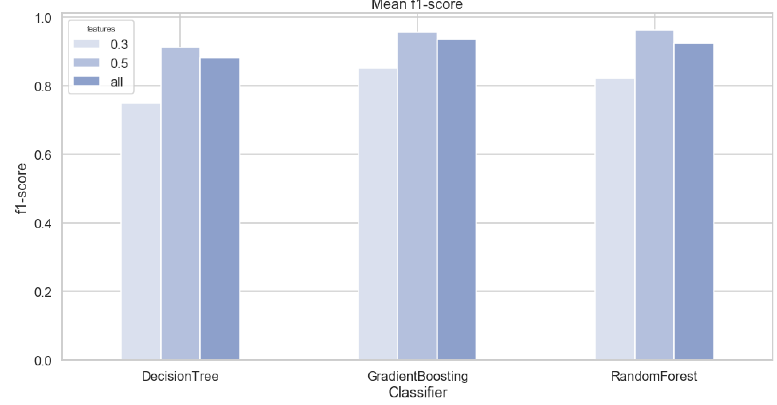
Figure 6. Average f-measure for the different